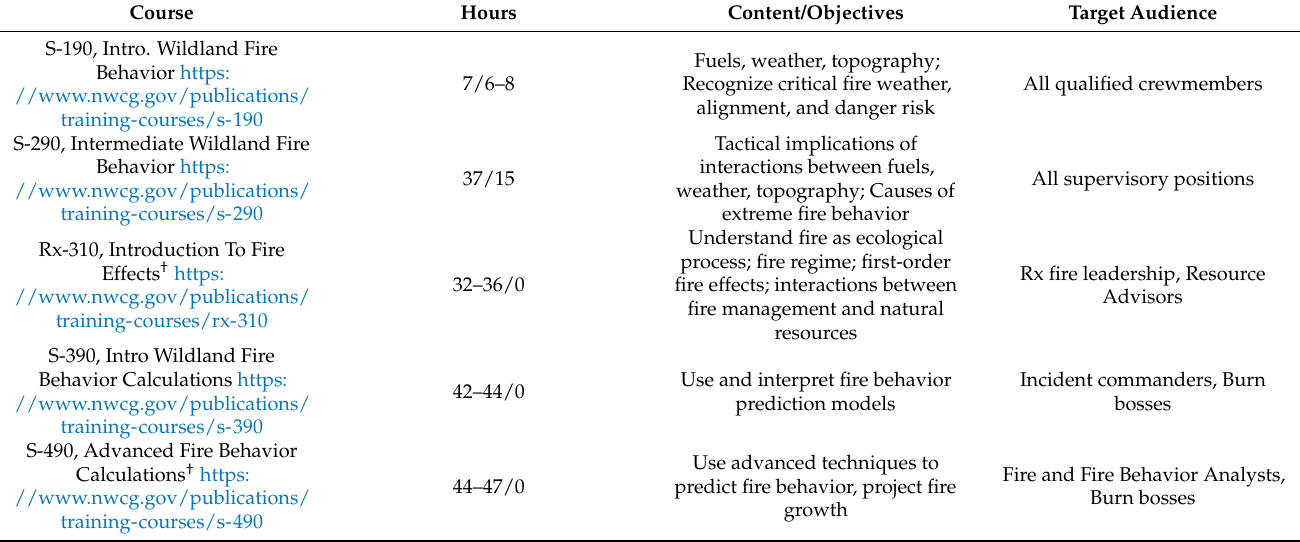
Table A1. Courses in wildland fire behavior and fire ecology available through the National Wildfire Coordinating Group (NWCG) current training curriculum. Hours column includes hours of instruc- tion, both instructor-led and/or self-directed, as appropriate. † Note that both Rx-310 and S-490 are followed by specialized intensive 500-level courses that are required to complete their